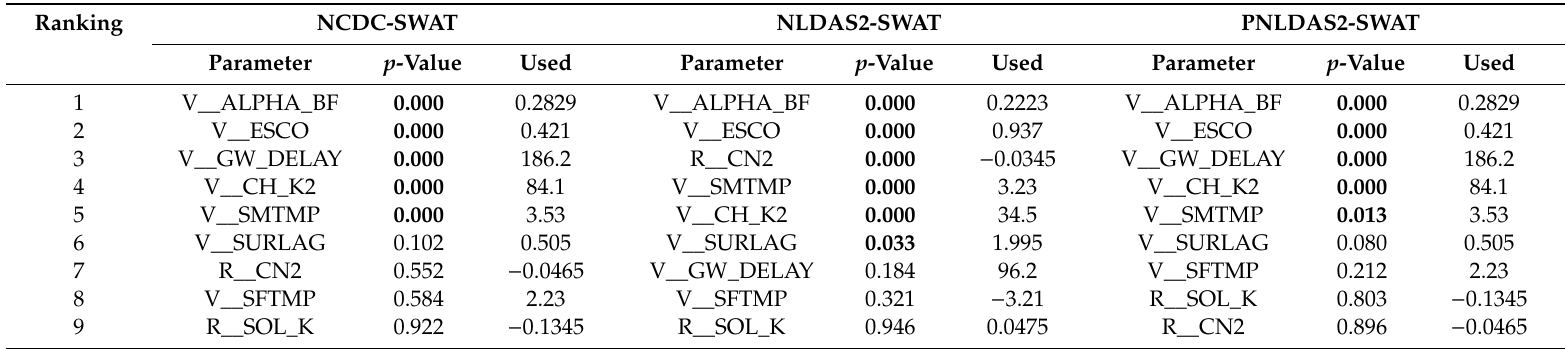
Table 2. Calibrated hydrology parameters and their best simulation values and sensitivity ranking in three simulation scenarios. Ranking NCDC-SWAT NLDAS2-SWAT PNLDAS2-SWAT Parameter p -Value